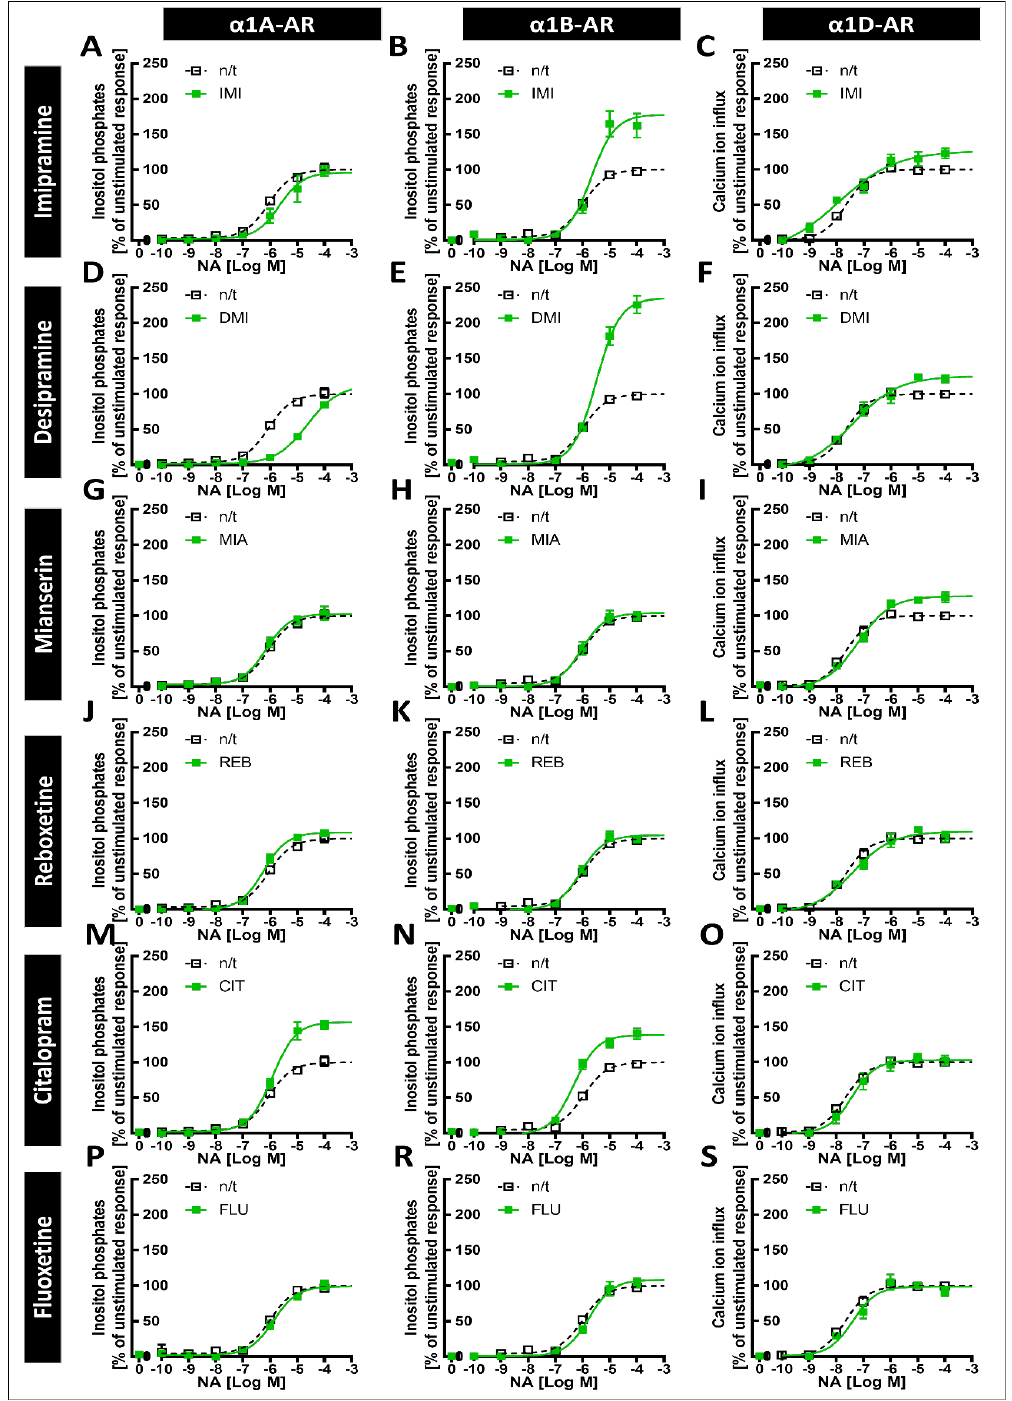
Figure 5. Dose–response curves for noradrenaline and the α 1A-, α 1B- and α 1D-adrenergic receptor subtypes’ second messenger responses after a 24 h preincubation with the chosen antidepressant drugs. The graphs show the responses of cells after preincubation with the antidepressant imipramine (IMI, ( A – C )), desipramine (DMI, ( D – F )), mianserin (MIA, ( G – I )), reboxetine (REB, ( J – L )), citalopram (CIT, ( M – O )) or fluoxetine (FLU, P – S ) (green solid lines on the respective graphs), or the responses of control cells (black dotted lines on all graphs). The effects were tested by measuring the inositol phosphate production by cells expressing α1A -AR ( A , D , G , J , M , P ) or α1B -AR ( B , E , H , K , N , R ), or by measuring the noradrenaline-induced calciu m ion influx of ChemiSCREEN™ Ready -to- Assay™ α1DA -AR-expressing cells ( C , F , I , L , O , S ). Each value represents the mean ± S.E.M. of at least four independent experiments conducted in duplicate.